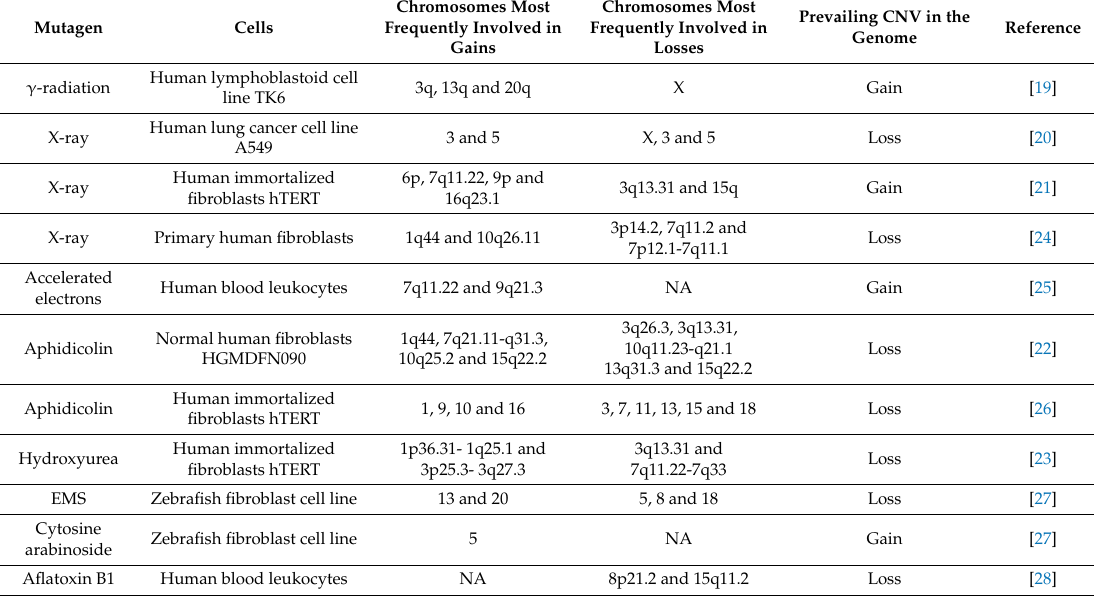
Table 1. Summary of studies on induction of copy number variations (CNVs) using radiation